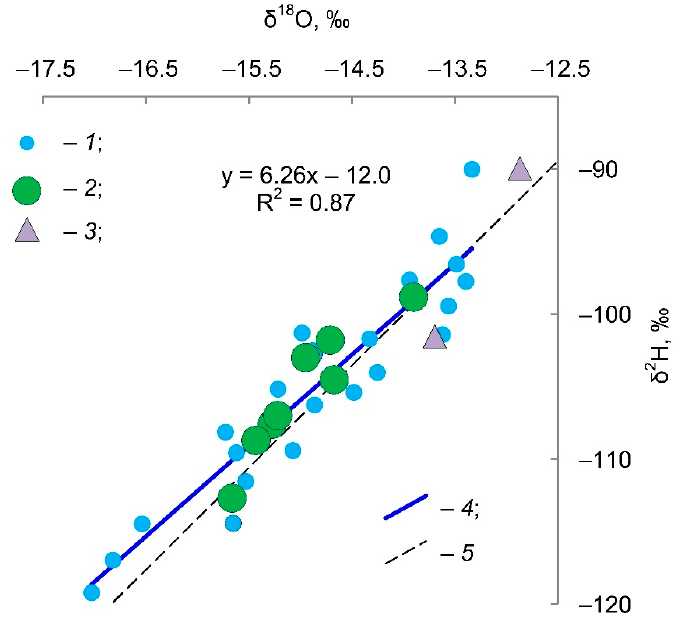
Figure 8. The stable isotopes composition of groundwater in the Pre-Volga region: 1 —points without anomalies of the isotopic composition of uranium ( 234 U/ 238 U < 7.8); 2 —points with anomalies of the uranium isotopic composition; 3 —outliers; 4 —the linear approximation of the total data (equation in the diagram); and 5 —local meteoric water line.